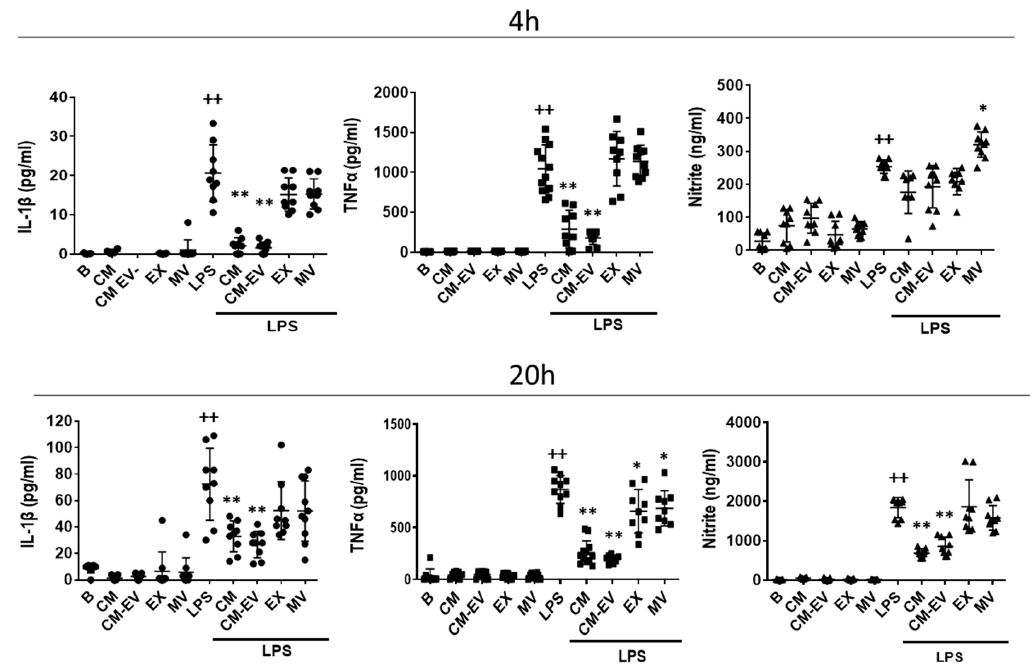
Figure 2. Release of pro-inflammatory mediators by mouse-derived peritoneal macrophages. Cytokines were measured by ELISA and nitrite was determined by fluorometry in cell supernatants at 4 h and 20 h of incubation with CM, CM-EV, EX, or MV in the presence or absence of LPS. B: cells incubated with control medium and not stimulated with LPS. Data are presented as mean ± SD ( n = 9) from 3 independent experiments. One-way analysis of variance followed by Tukey’s post hoc test; ++ p < 0.001 versus B; * p < 0.05, ** p < 0.01 versus LPS control.